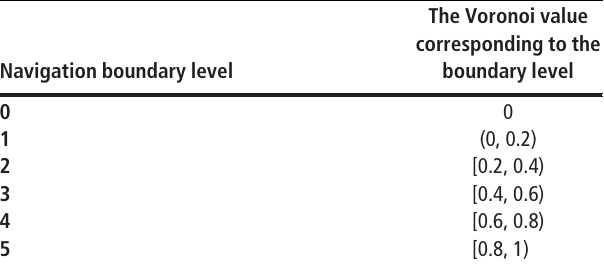
Table 1 Navigation area boundary and its corresponding Voronoi fi eld value